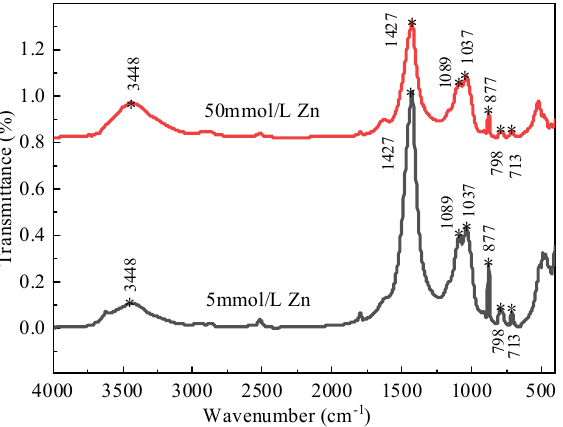
Figure 12. FTIR spectra of bentonite adsorbed Zn 2+ of different concentrations (25